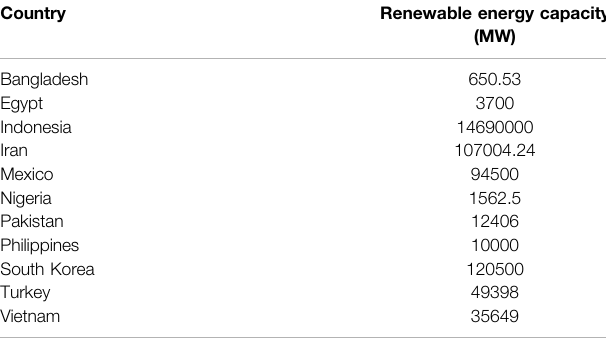
TABLE 6 | Renewable energy capacity in 11